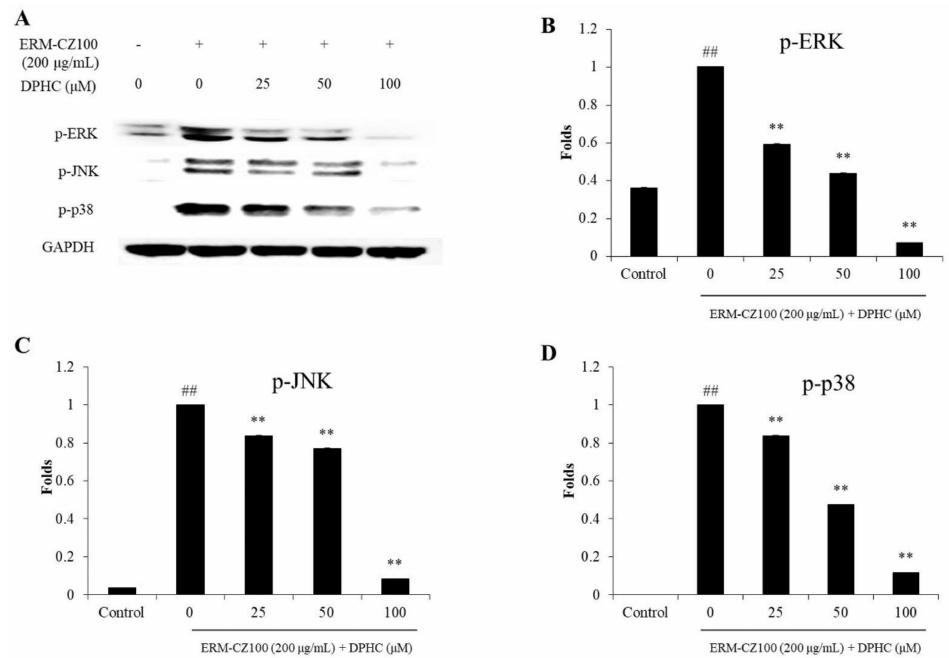
Figure 5. DPHC inhibited NF- κ B activation and AP-1 phosphorylation in ERM-CZ100-stimulated HDF cells. ( A ) The nuclear NF- κ B-related proteins (p65 and p50) and phosphorylated AP-1 (p-c-Jun) levels in ERM-CZ100-stimulated HDF cells, and relative amounts of NF- κ B p50 ( B ), NF- κ B p65 ( C ), and p-c-Jun ( D ) levels in ERM-CZ100-stimulated HDF cells. The relative amounts of NF- κ B p65, NF- κ B p50, and p-c-Jun levels were compared with nucleolin. The data were expressed as the mean ± SE ( n = 3). * p < 0.05, ** p < 0.01 as compared to the ERM-CZ100-treated group and ## p < 0.01 as compared to the control group.